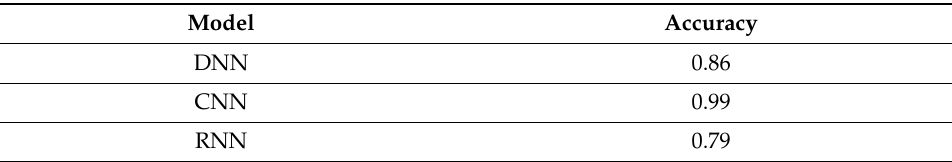
Table 5. Performance of each model for detecting combined